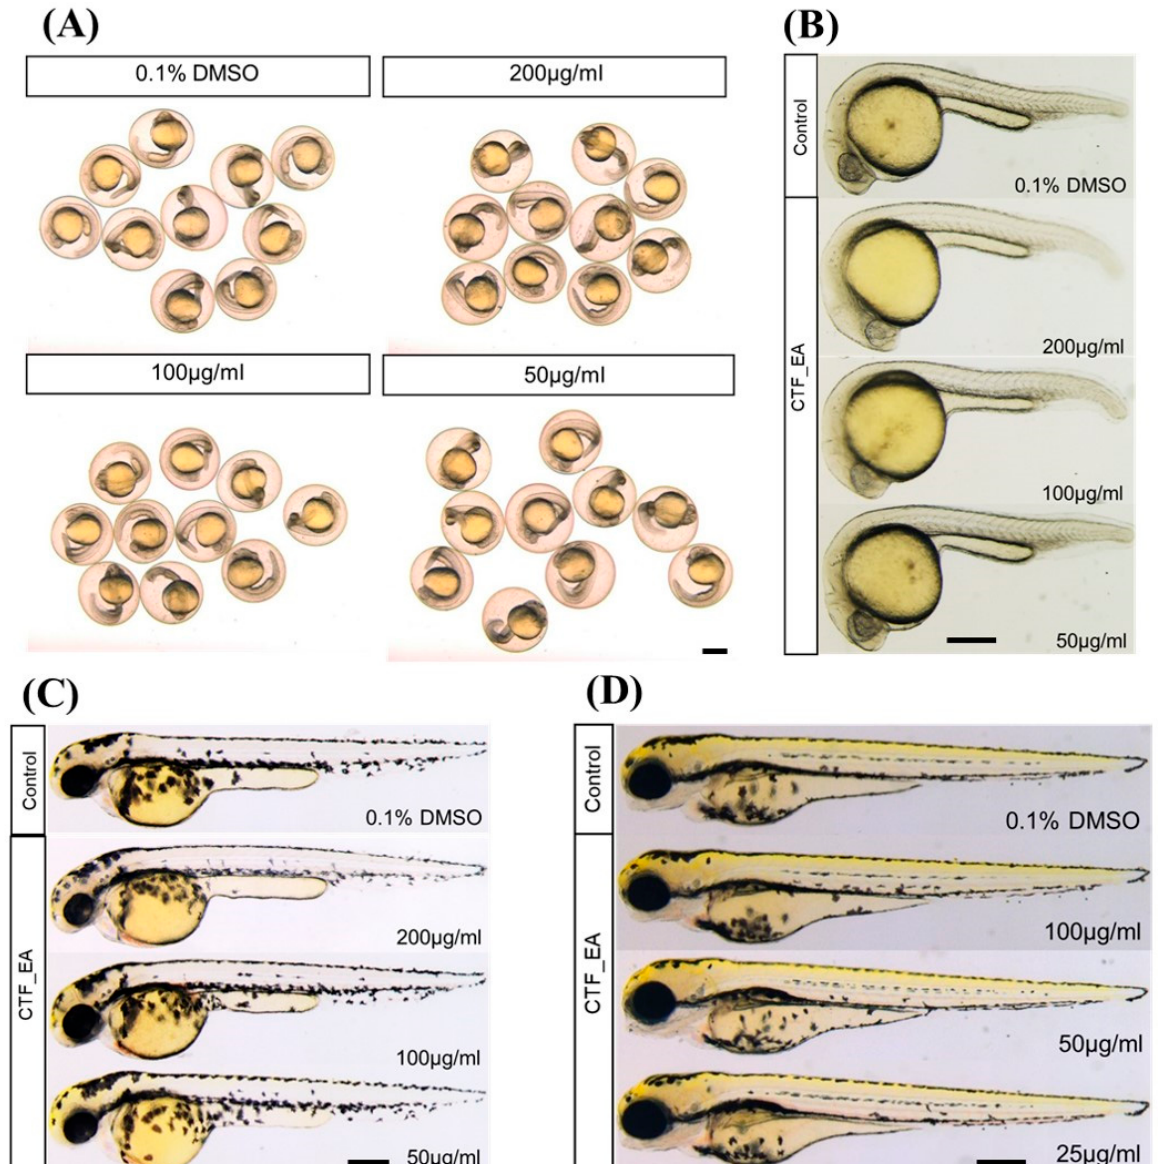
Figure 16. Morphological characteristics of zebrafish larvae at different developmental stages of ( A ) 24 hpf, ( B ) 24 hpf (dechorionated zebrafish), ( C ) 48 hpf, and ( D ) 72 hpf with CTF_EA fraction at concentrations of 200 µ g/mL, 100 µ g/mL, and 50 µ g/mL. The changes in body size, yolk expansion, somite boundary, and pigment cell development, as well as heart rate and blood circulation (data not shown), were observed and measured. Scale bar, 200 µ